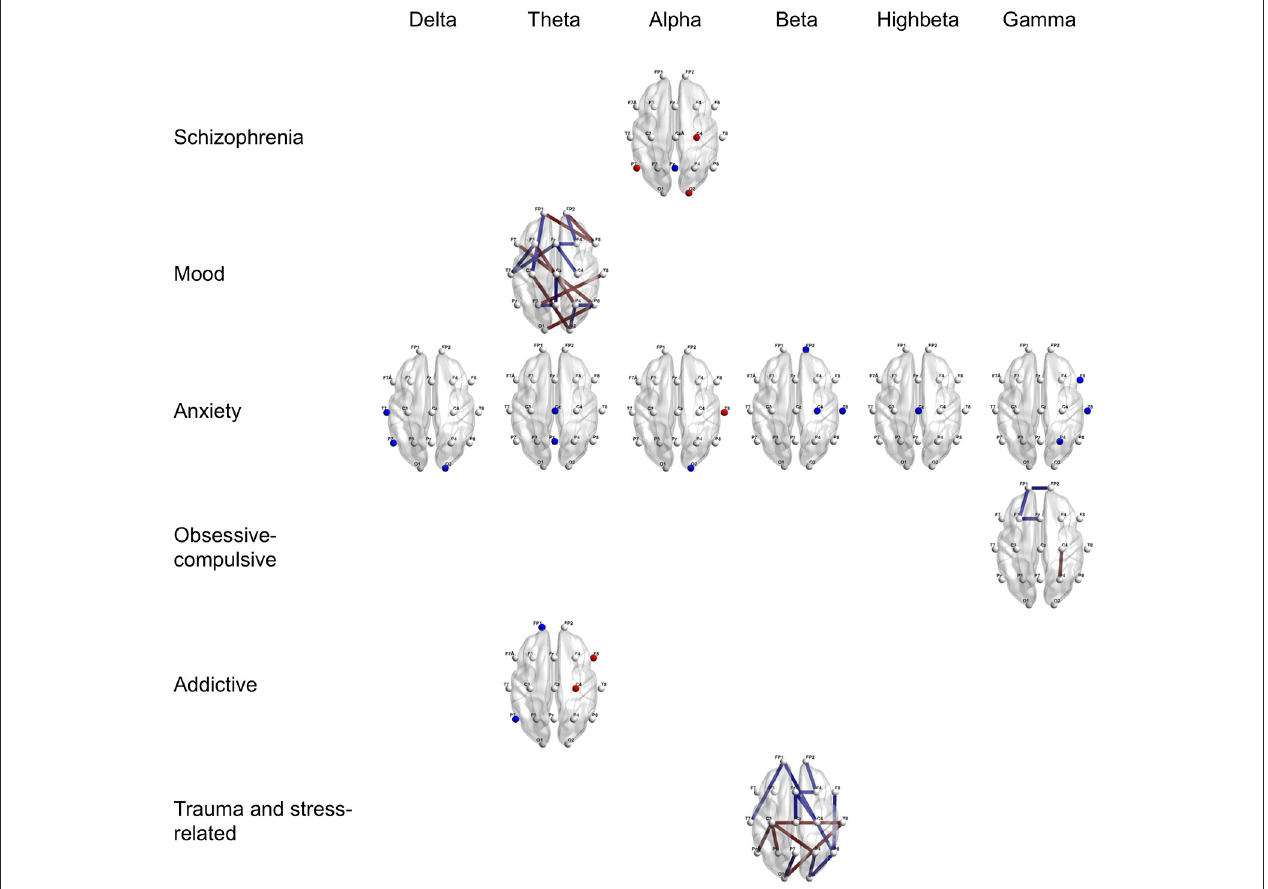
FIGURE 2 | Region-wise predictions for main categories of psychiatric disorders distinguished from healthy controls. Dots and lines represent region-wise survived predictors in the best EN model, which emerged significant above 7 times during 10 times of cross-validation. Dots mean channel-level PSD (absolute power) as QEEG parameter and lines mean channel-level FC (coherence) as QEEG parameter. Features colored in red represent higher probabilities for the psychiatric disorder when more increase. Features colored in blue represent higher probabilities for the psychiatric disorder when more decrease. Age, sex, the year of education, and the IQ score were computed in the models. EN, Elastic Net; PSD, Power Spectrum Density; FC, Functional Connectivity; QEEG, Quantitative Electroencephalography; and IQ, Intelligence